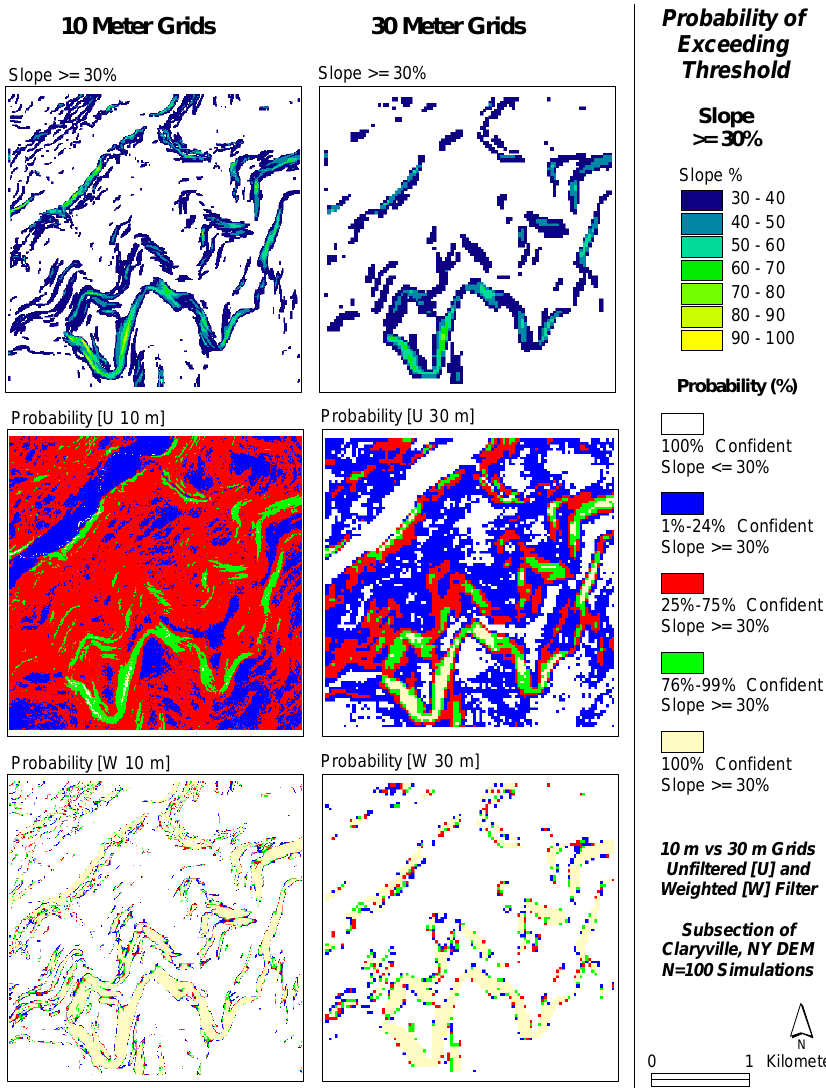
Fig. 2. Results of a Monte Carlo simulation demonstrating the probability that slopes will be >= 30%. Two methods for generating random fields were used: U corresponds to uncorrelated random fields and W represents spatially autocorrelated random fields. The results demonstrate the effects of uncertainty using two different random field methods and grid cell resolutions (10 and 30m).